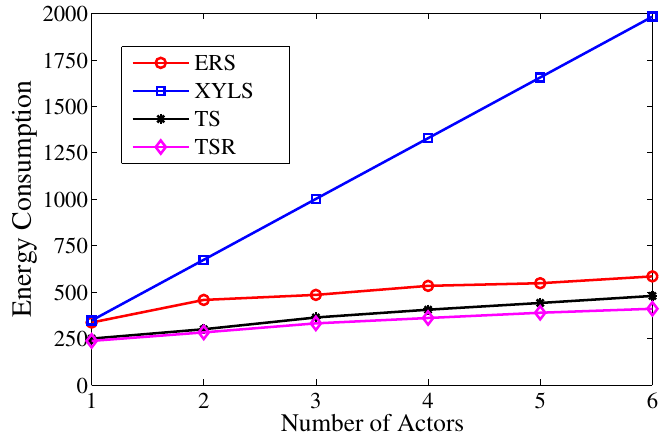
Figure 14. The energy consumption over the number of actors.